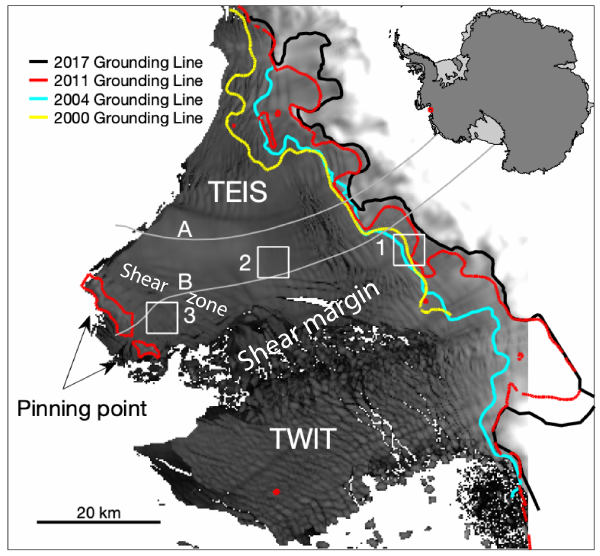
Figure 1. Location map; the Thwaites Eastern Ice Shelf (TEIS) and Thwaites Western Ice Tongue (TWIT) are labelled. We also indi- cate the “pinning point,” the “shear zone” upstream of the pinning point, and the “shear margin” between the TEIS and the TWIT, which are terms discussed in the text. Three 5km × 5km sites of interest are shown, which are referred to in the text as the “ground- ing zone” (site 1), “mid-shelf” (site 2), and pinning point (site 3) areas. Data from these sites are shown in Figs. 2 and 5. Flowlines based on 2015–2020 velocities, labelled A and B, are represented in Hovmöller diagrams in Figs. 3 and 6. Grounding lines are from ap- proximately 2000 (Rignot et al., 2016), 2004 (Bindschadler et al., 2011), 2011 (Rignot et al., 2016), and 2017 (Milillo et al., 2019). Figure created using the Antarctic Mapping Tools for MATLAB (Greene et al.,